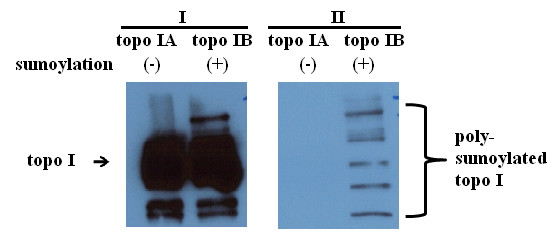
Western blots show sumoylation of recombinant human topo I. Recombinant human topo I protein was subjected to the sumoylation reaction and examined by Western blotting using anti-topo I (I) and anti-SUMO1 antibodies (II). Compared to topo I protein without sumoylation reaction (topo I A), topo I protein with sumoylation reaction (topo I B) showed poly-sumoylation of topo I (II). The assays showed similar results in triplicates.